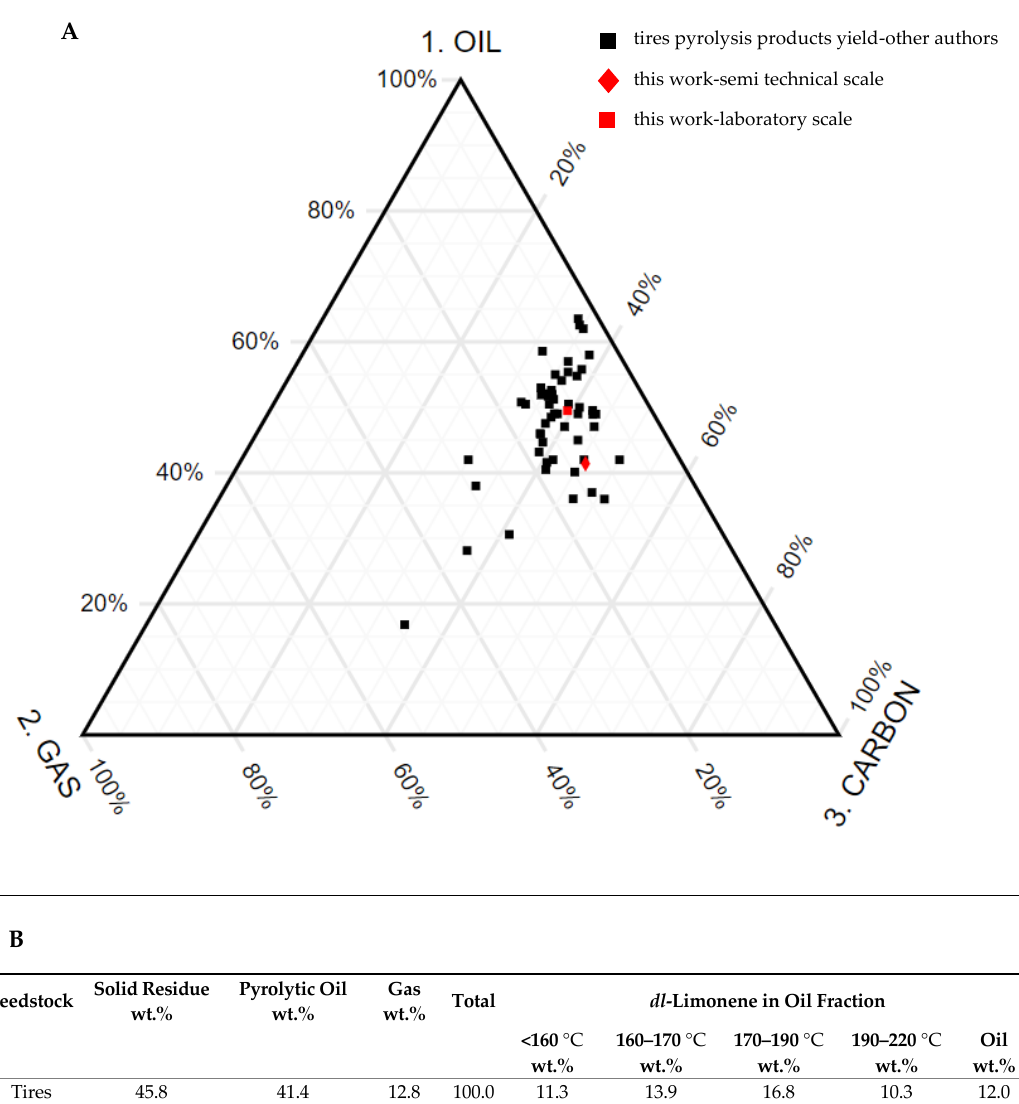
Figure 6. ( A ) Comparison of the results obtained in this study in the semi-technical scale (red diamond) and laboratory scale (red square), expressed as product fractions (wt.%), with the results of different authors [8] obtained by tire pyrolysis performed in different types of reactors; ( B ) The results of tire pyrolysis: product yields and limonene content in the oil fraction.